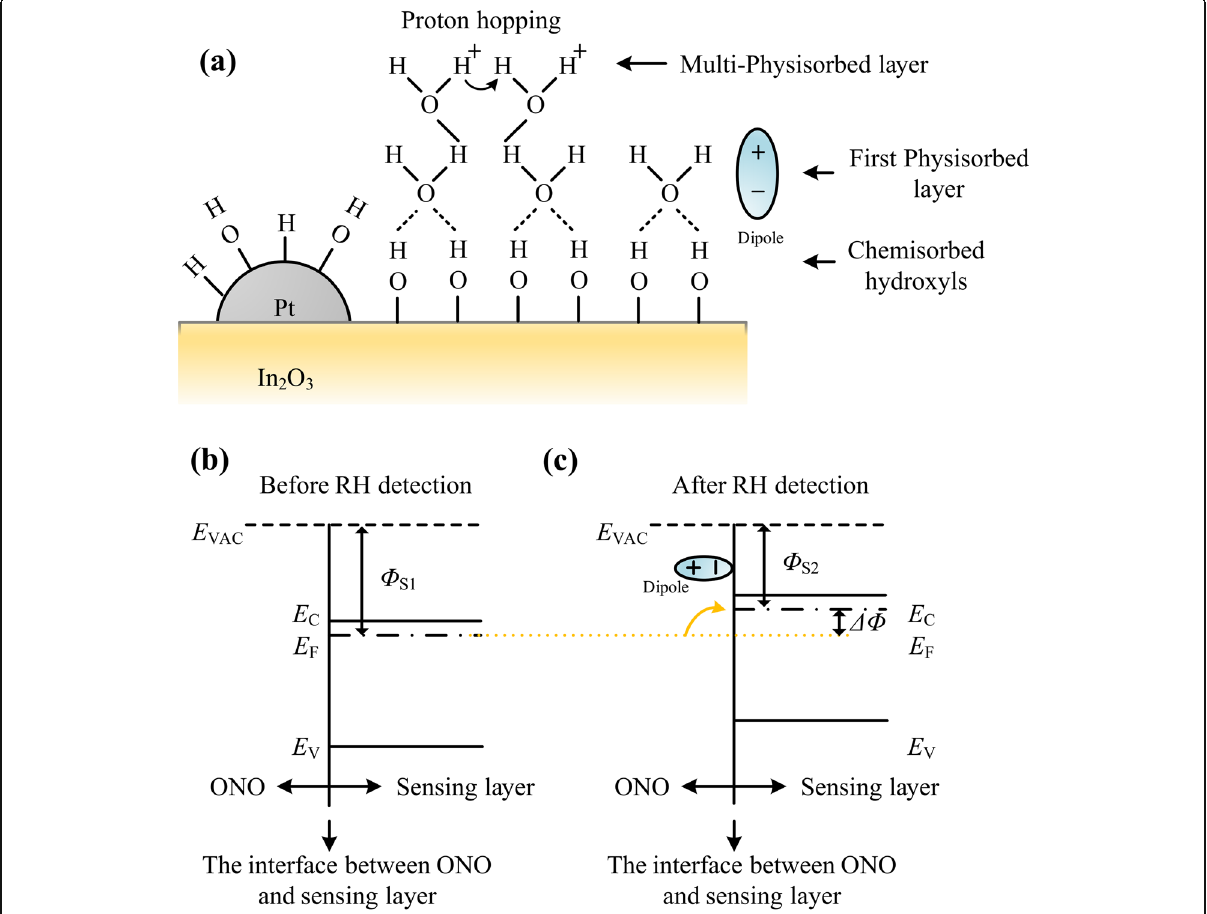
Fig. 6 Schematic water molecule adsorption and related energy band diagrams. a Chemisorption and physisorption layers of water molecules on Pt-In 2 O 3 sensing material. b The energy band diagram near the interface between the ONO stack and sensing layer before RH detection. It was assumed to be at a flat band state. c The energy band diagram after RH detection. Dipoles at the interface decrease the work function of the sensing